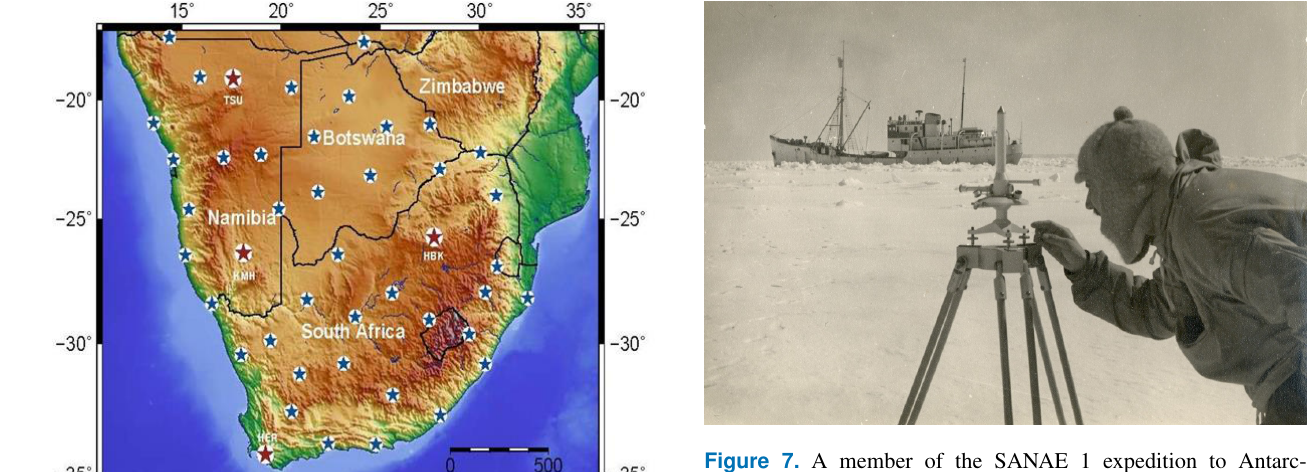
Figure 7. A member of the SANAE 1 expedition to Antarc- tica in 1960 taking measurements of the horizontal component of the Earth’s magnetic field with a quartz horizontal magnetometer (QHM) instrument, with the ship, the Polarhav , in the